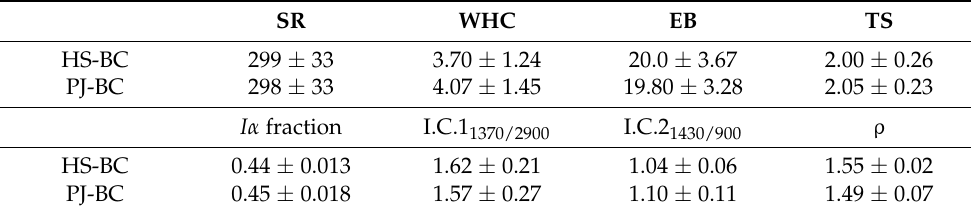
Table 2. Selected parameters of BC pellicles synthesized by K. xylinus ATCC 53524 in HS and PJ